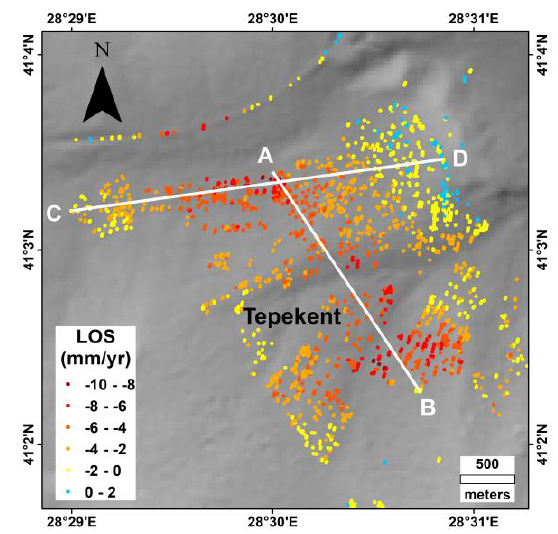
Figure 4. Profiles along the topography and PSI velocity